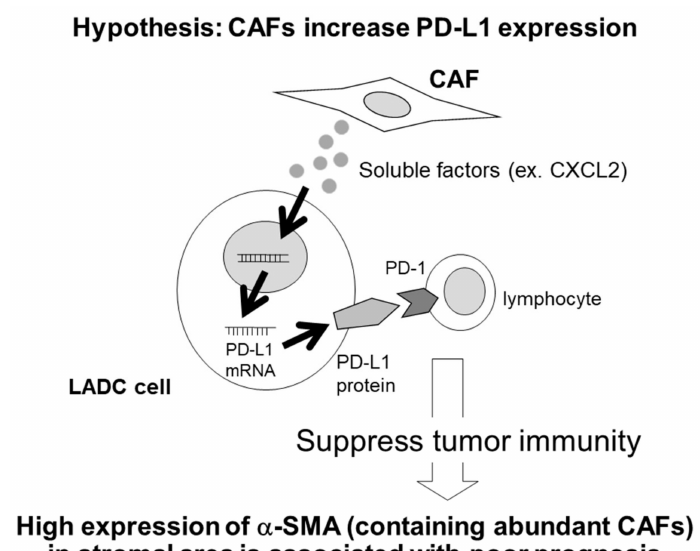
Figure 6. Proposed PD-L1 expression in interaction of cancer-associated fibroblasts (CAFs) and lung adenocarcinoma (LADC) cells. PD-L1 expression is induced by soluble factors such as CXCL2 derived from CAFs in the LADC cell. Interaction of PD-L1 with programmed death 1 (PD-1) contributes to the immune escape and poor prognosis of tumour